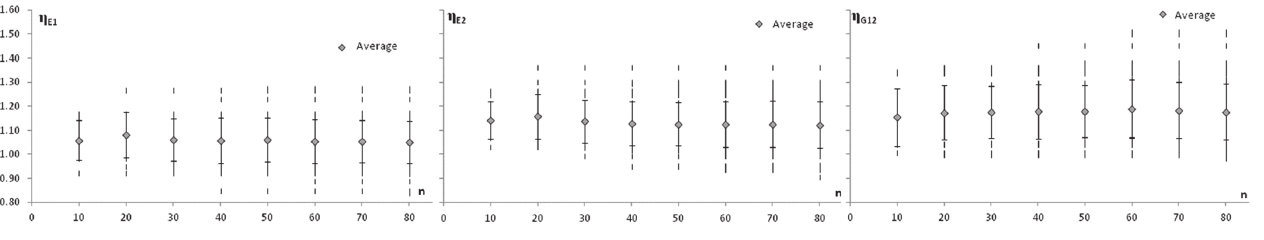
Figure 15: Sensitivity analysis. Effect of the number of specimens: a)  E1,A ; b)  E2,A ; c)  G12,A .